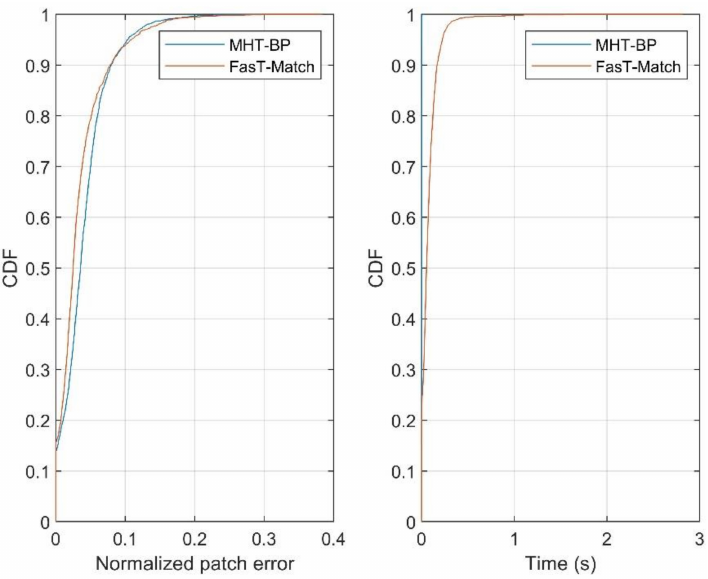
Figure 5. CDF of normalized patch error and consumed time for MHT-BP and FasT-Match.